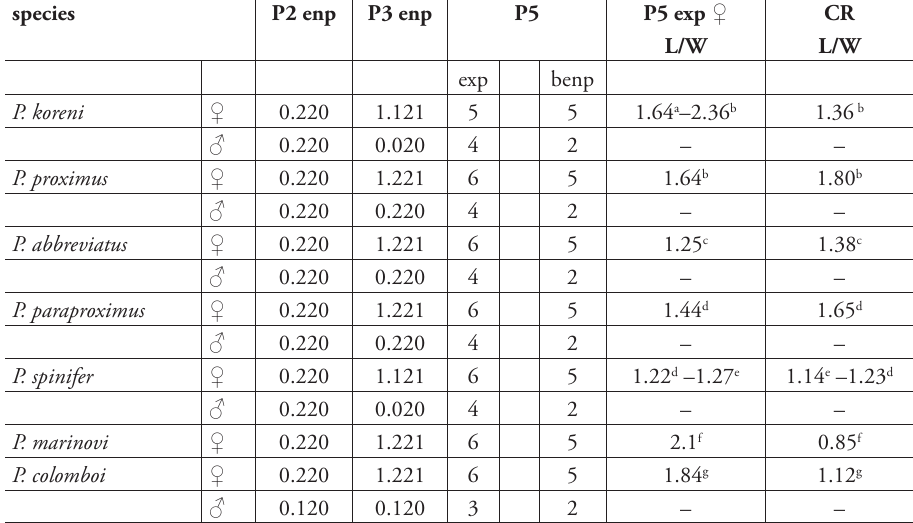
Table 2. Setal number and morphometric diff erences between species of Pseudonychocamptus (CR = cau- dal ramus; exp = exopod; enp = endopod; benp = baseoendopod). Length/width ratios based on Chislenko (1967) a , Sars (1908a) b , Sars (1920a) c , Lang (1965) d , Letova (1982) e , Apostolov and Petkovski (1980) f and Ceccherelli (1988) g